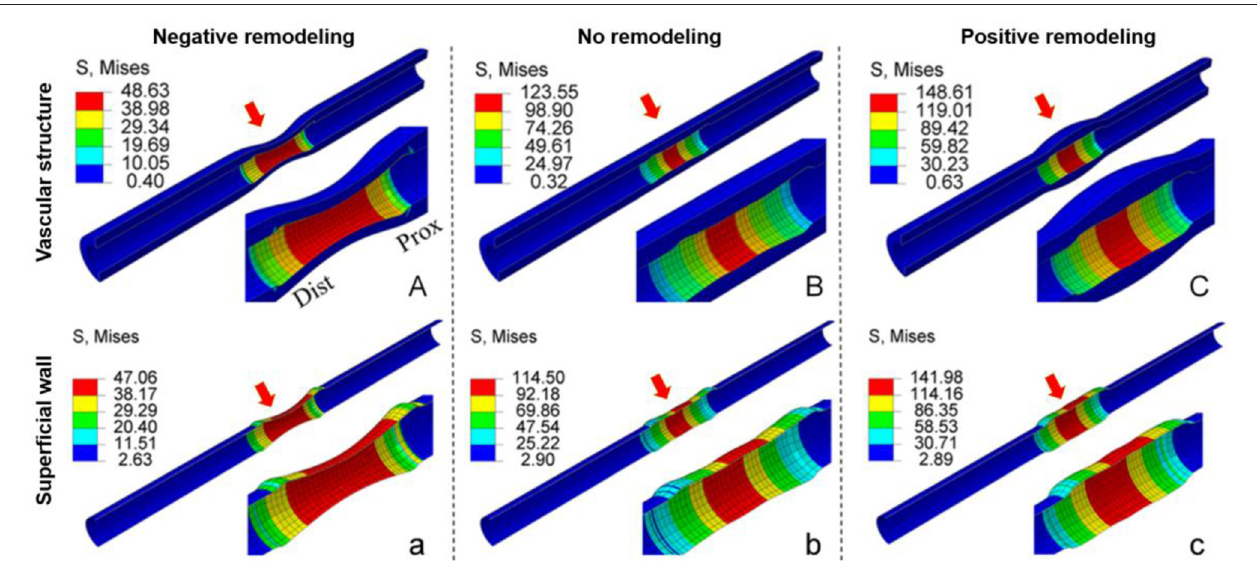
FIGURE 4 | Comparison of the stress distribution of lipid-rich plaque models calculated by the conventional structural mechanical force-based method and superficial wall displacement-based method. There is similar wall stress distribution along the longitudinal superficial wall of the lipid-rich plaque models calculated by the conventional structural mechanical force-based method (A–C) and by superficial wall displacement-based method (a–c) , regardless of the presence of arterial remodeling. Prox: Proximal; Dist: distal. Six red arrows show the lesion segments of two structural models with three types of arterial remodeling. Modified from Wu et al.